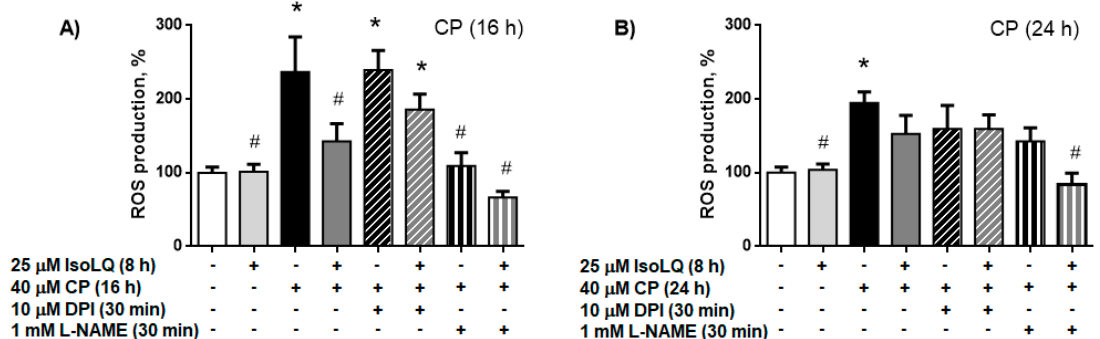
Figure 7. Nitric oxide synthase (NOS), but not nicotinamide adenine dinucleotide phosphate hydrogen (NADPH) oxidase (NOX), is the source of reactive oxygen species (ROS) production in LLC-PK1 cells pretreated with 25 µ M isoliquiritigenin (IsoLQ, 8 h) and subsequently with 40 µ M cisplatin (CP). Diphenyleneiodonium chloride (DPI), N-nitro-L-arginine methyl ester (L-NAME). ( A ) 16 h CP treatment. ( B ) 24 h CP treatment. Data are mean ± SEM, n = 3. * p < 0.05 vs. control (without IsoLQ and CP), # p < 0.05 vs. CP.